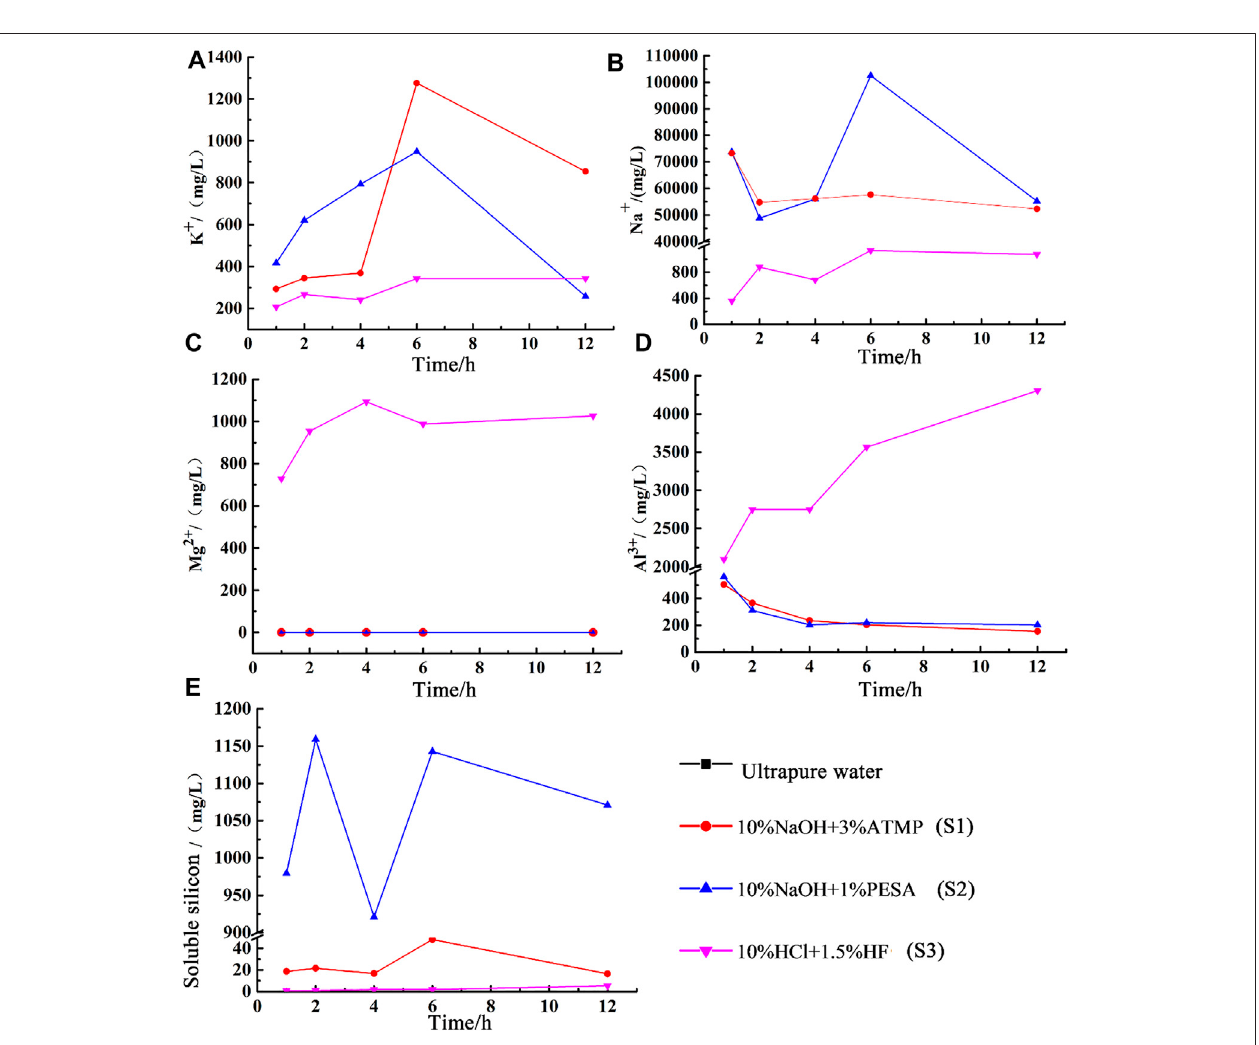
FIGURE 10 | Changes of chemical composition of the static experiment. (A) Concentration of K + ; (B) concentration of Na + ; (C) concentration of Mg 2+ ; (D) concentration of Al 3+ ; (E) concentration of Soluble silicon.